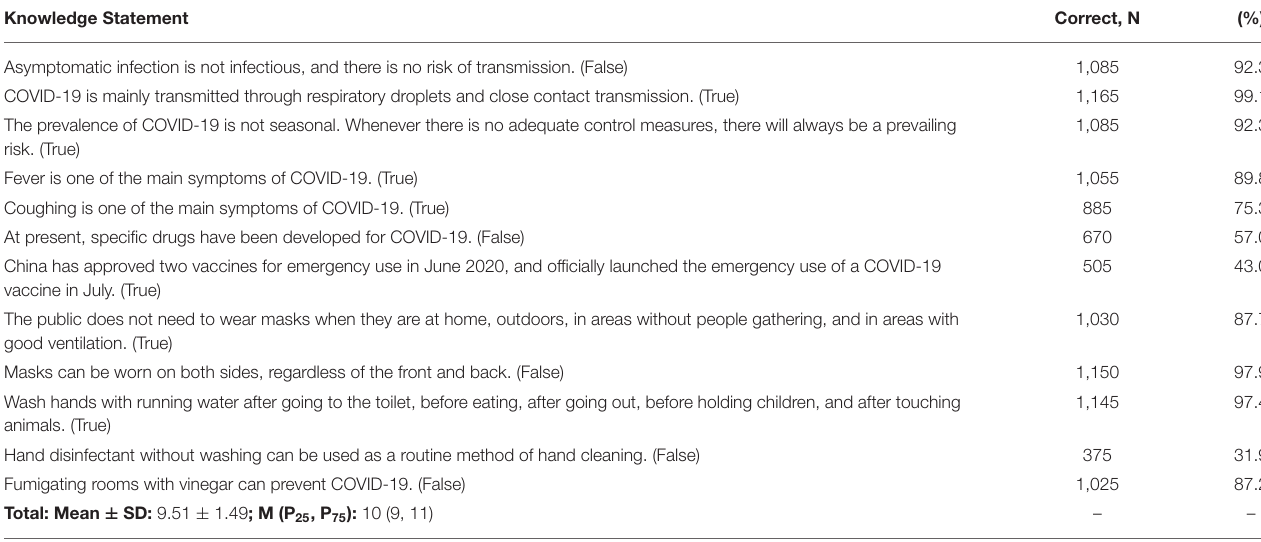
TABLE 2 | Knowledge of community residents regarding COVID-19 ( n = 1,175).